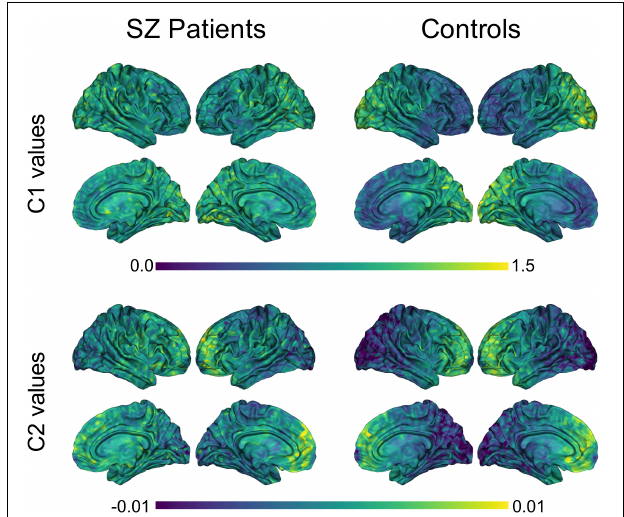
FIGURE 2 | Group averages of C1 and C2 values in SZ patients and controls. Averaged C1 and C2 values were computed for each of the 8,196 nodes, within each group. P-leader p = 2 was used. SZ,